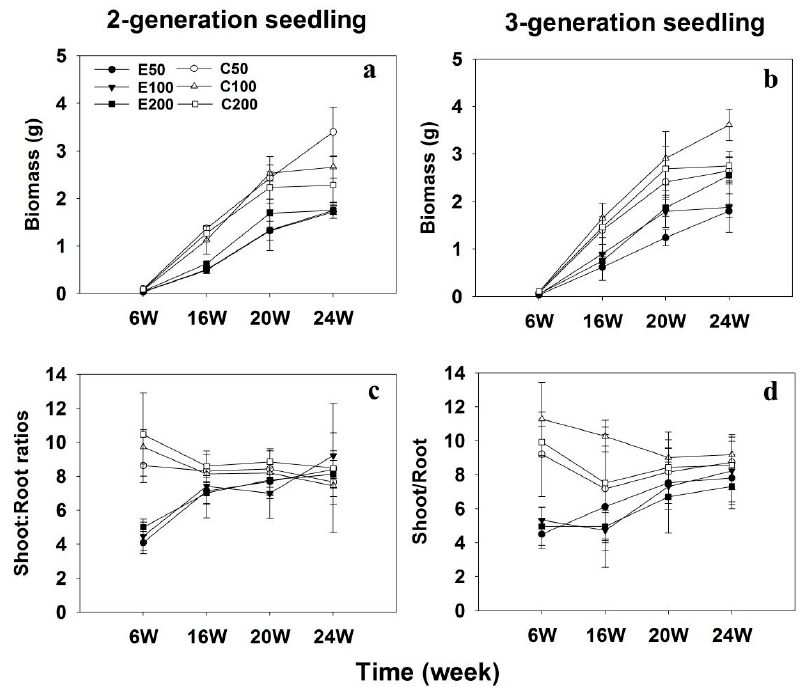
Figure 2. Biomass ( a , b ) and shoot:root ratio ( c , d ) in 2-generation and 3-generation Chinese fir seedlings under conventional and exponential fertilization regimes at three fertilization levels. C50, C100, and C200 indicate conventional fertilization delivering a seasonal total of 50, 100, and 200 mg P per seedling at a constant rate; E50, E100, and 200 indicate exponential fertilization adding a seasonal total of 50, 100, and 200 mg P per seedling.